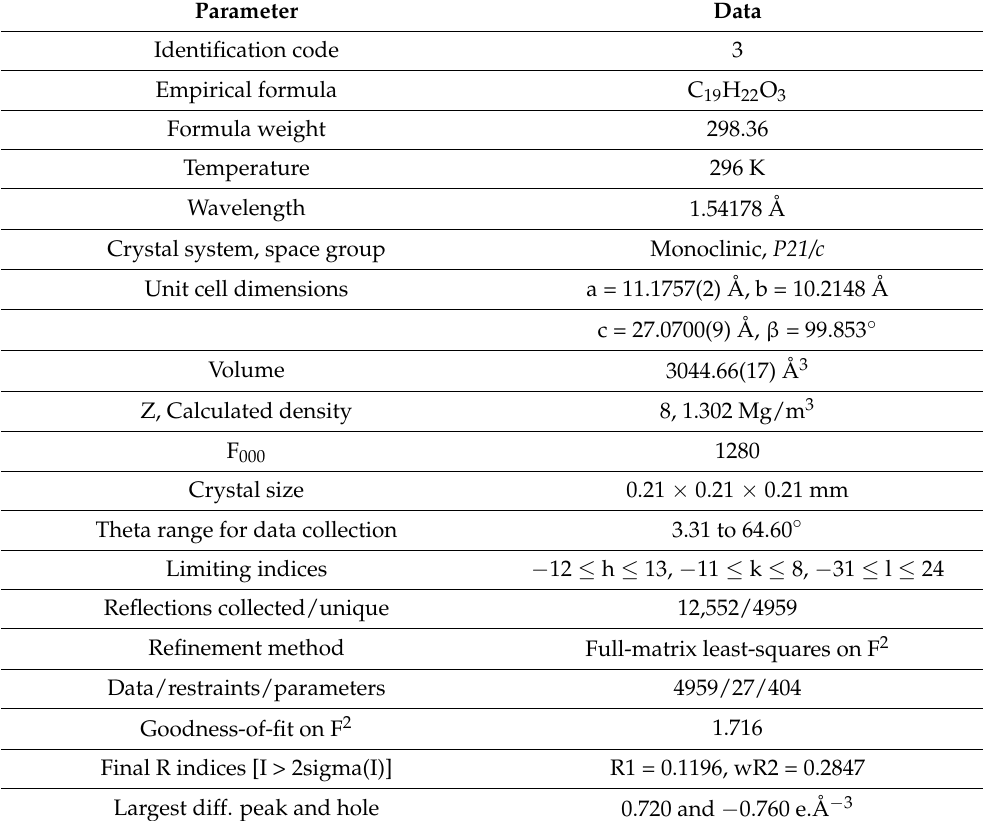
Table 1. Crystal data and structure refinement for